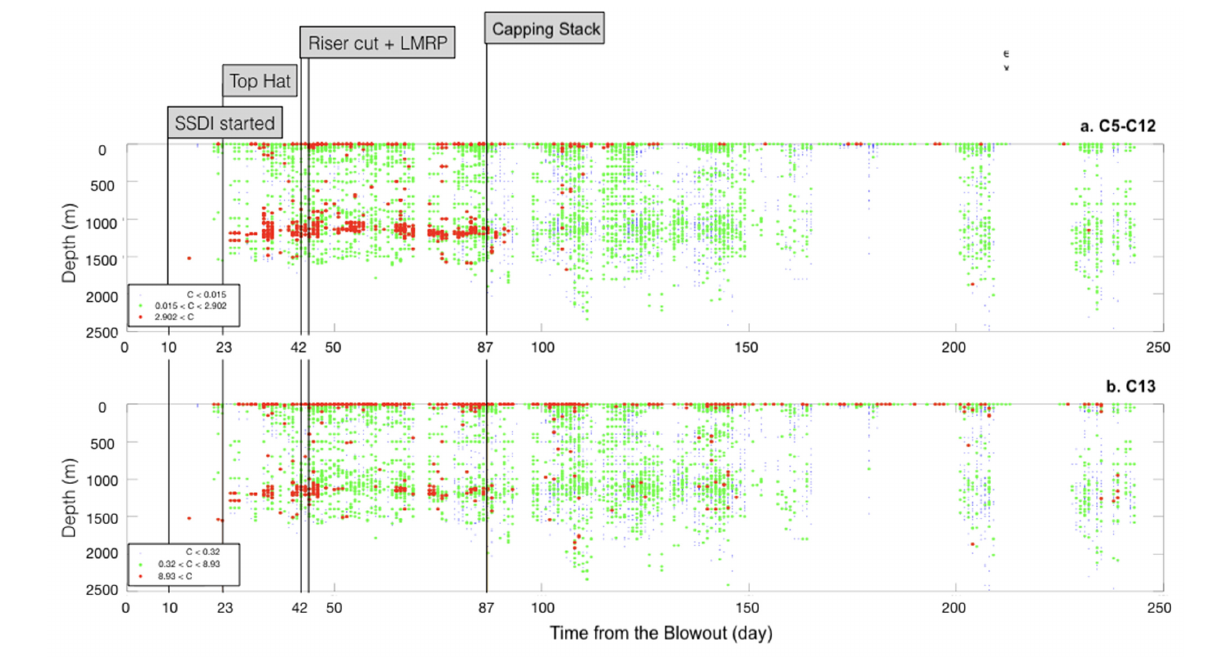
FIGURE 2 | Daily vertical distribution of petroleum hydrocarbon concentrations in the Gulf of Mexico (GoM) from the Deepwater Horizon blowout until December 31, 2010. (A) Concentrations of low (C5–C12) and (B) high (C13+) molecular weight hydrocarbon fractions. Values are computed into a grid of 10 m depth over the entire GoM. Oil-contaminated samples are represented by red dots for values above the 90 percentile (2.902 and 8.93 µ g/L for C5–C12 and C13+, respectively) and by green dots between the median and the 90 percentile (0.015 µ g/L < C5–C12 < 2.902 µ g/L and 0.32 µ g/L < C13+ < 8.93 µ g/L); blue dots are samples that are below the median to uncontaminated samples (0–0.015 µ g/L and 0–0.32 µ g/L for C5–C12 and C13+, respectively); white area has no samples. The key dates of the various attempts to stop the oil spill are indicated: (1) SSDI started on April 30 (day 10 after the blowout); (2) top hat on May 13 (day 23); (3) riser cut followed by the Lower Marine Riser Package (LMRP) on June 4th (day 42); and (4) finally the Stacking Cap on June 15th (day 87). Note: no data were recorded in BP Gulf Science Data (GSD) before May 5,